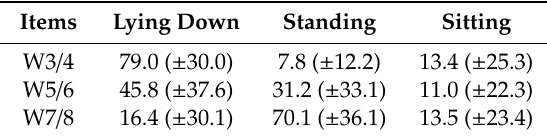
Table 4. Evolution of the nursing position of the bitches throughout the weaning period (percentage of total time spent to nurse +